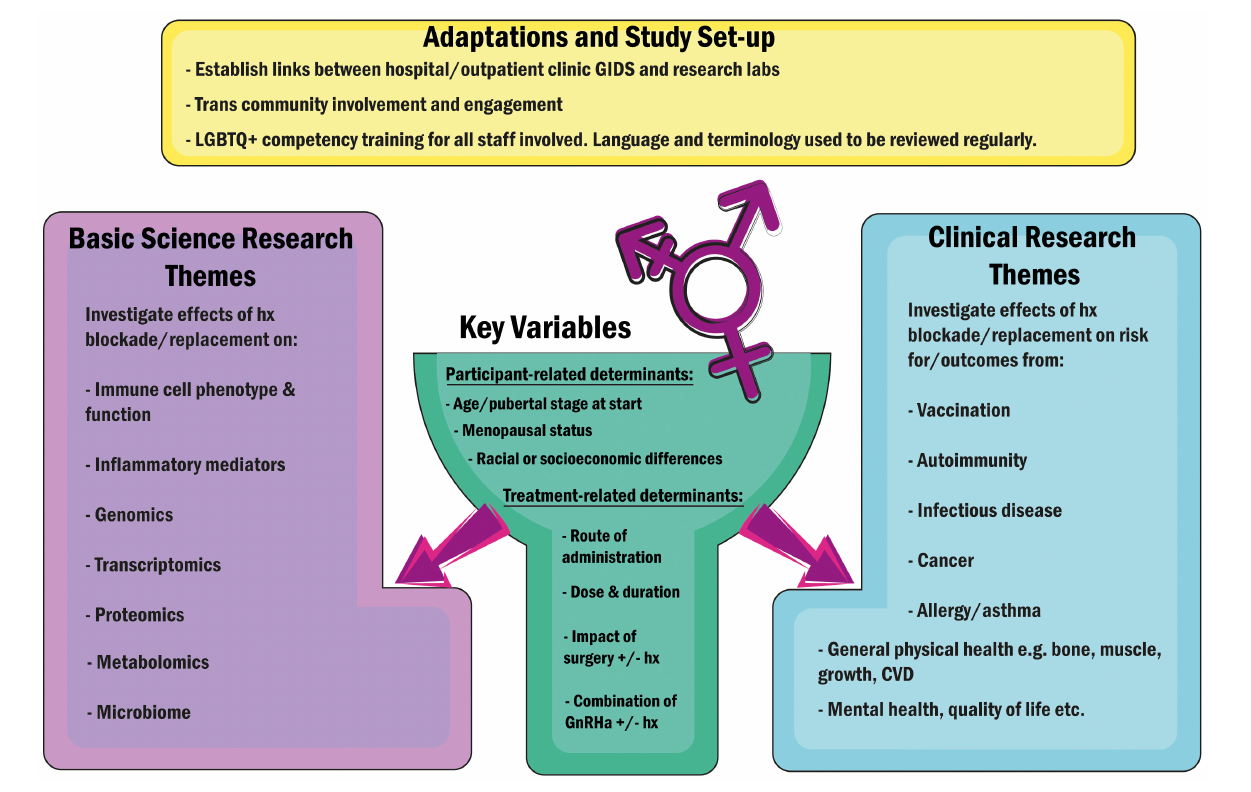
FIGURE 2 | Suggested adaptations to facilitate future research encompassing trans and gender-diverse individuals, and key research pathways proposed. Hx, Hormones; GnRHa, Gonadotropin Releasing Hormone Agonists (“Blockers”); CVD, Cardiovascular Disease.